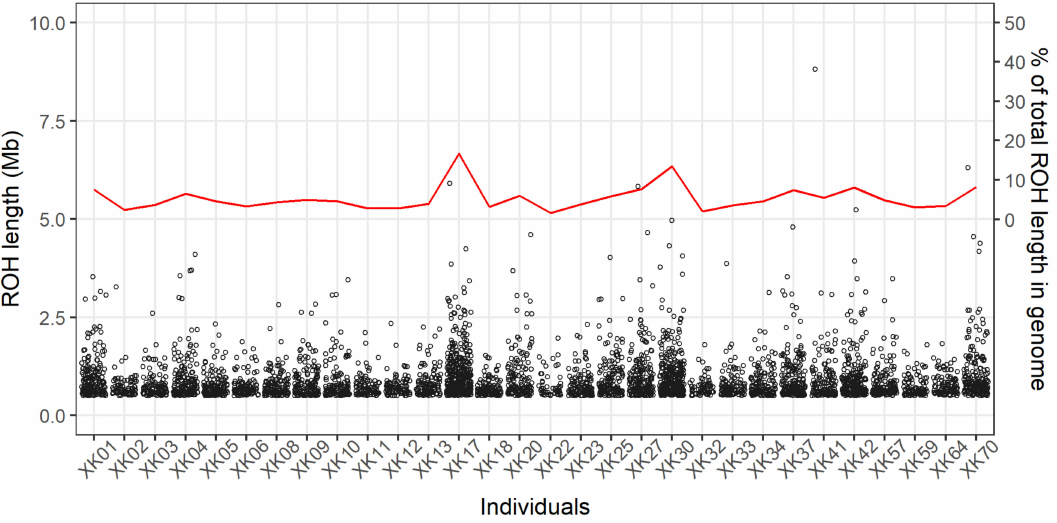
Figure 2. Numbers and lengths of runs of homozygosity. All runs of homozygosity are represented by the hollow points with their lengths showing on the left-hand y-axis. The individual genomic proportions (the red line) for total length of runs of homozygosity are shown in the right-hand y-axis.